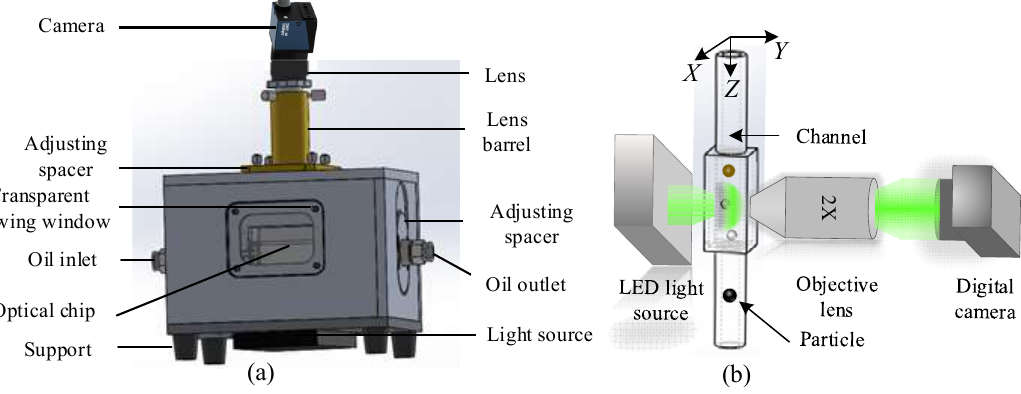
Figure 13. ( a ) Three-dimensional model of the particle monitoring sensor. ( b ) Schematic of sensor.